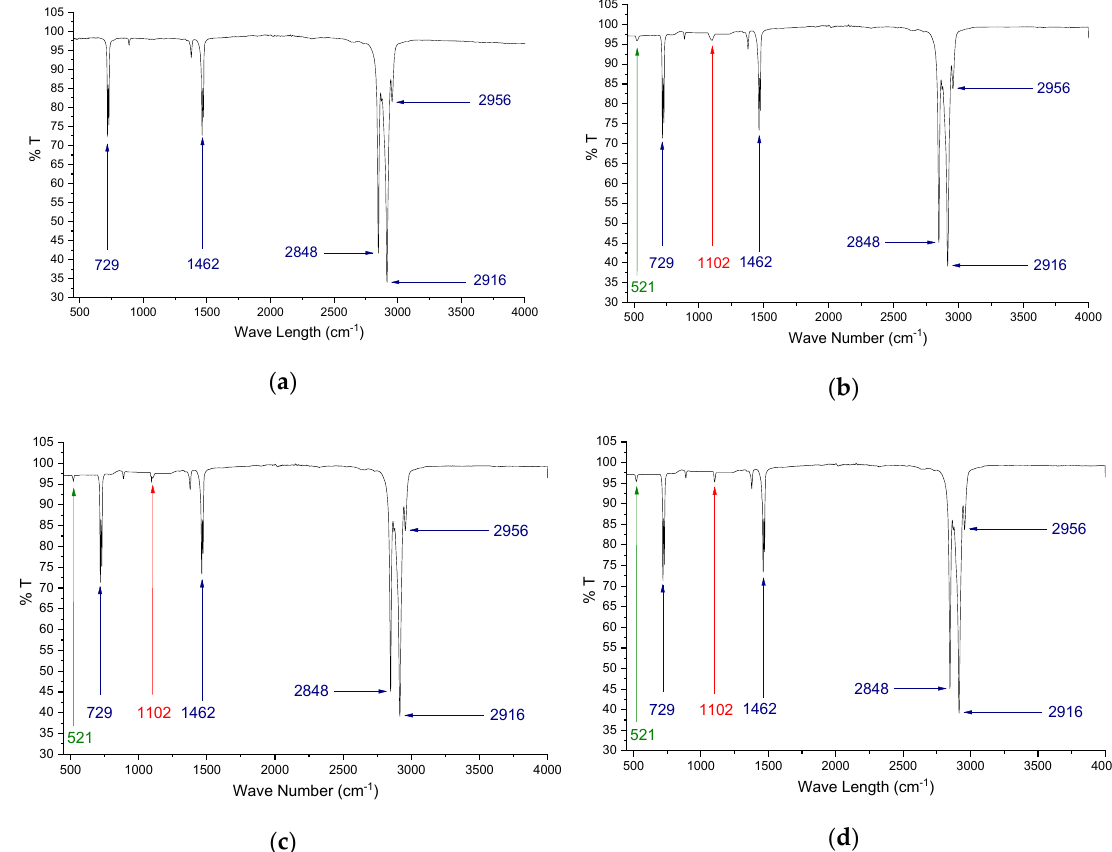
Figure 4. Fourier transform infrared spectrometer (FTIR) results of ( a ) Pure paraffin ( b ) 0.5 HnP ( c ) 1.0 HnP ( d ) 2.0 HnP.